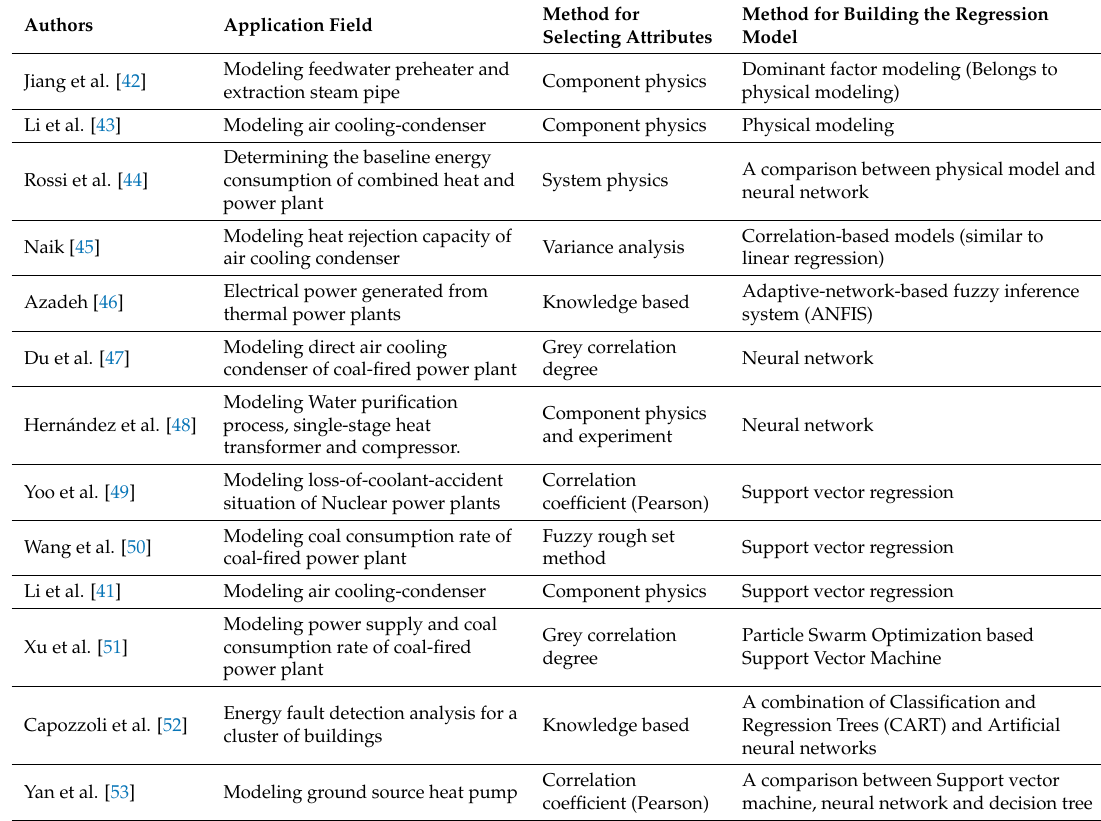
Table 2. A review of recent data-driven modeling for components or subsystems in energy